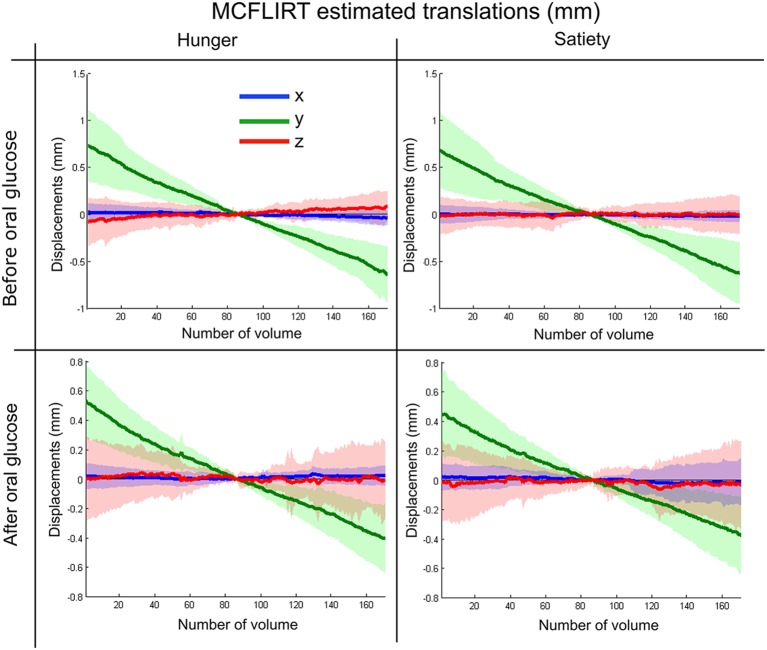
Summary of MCFLIRT estimated translation parameters for each experimental condition.